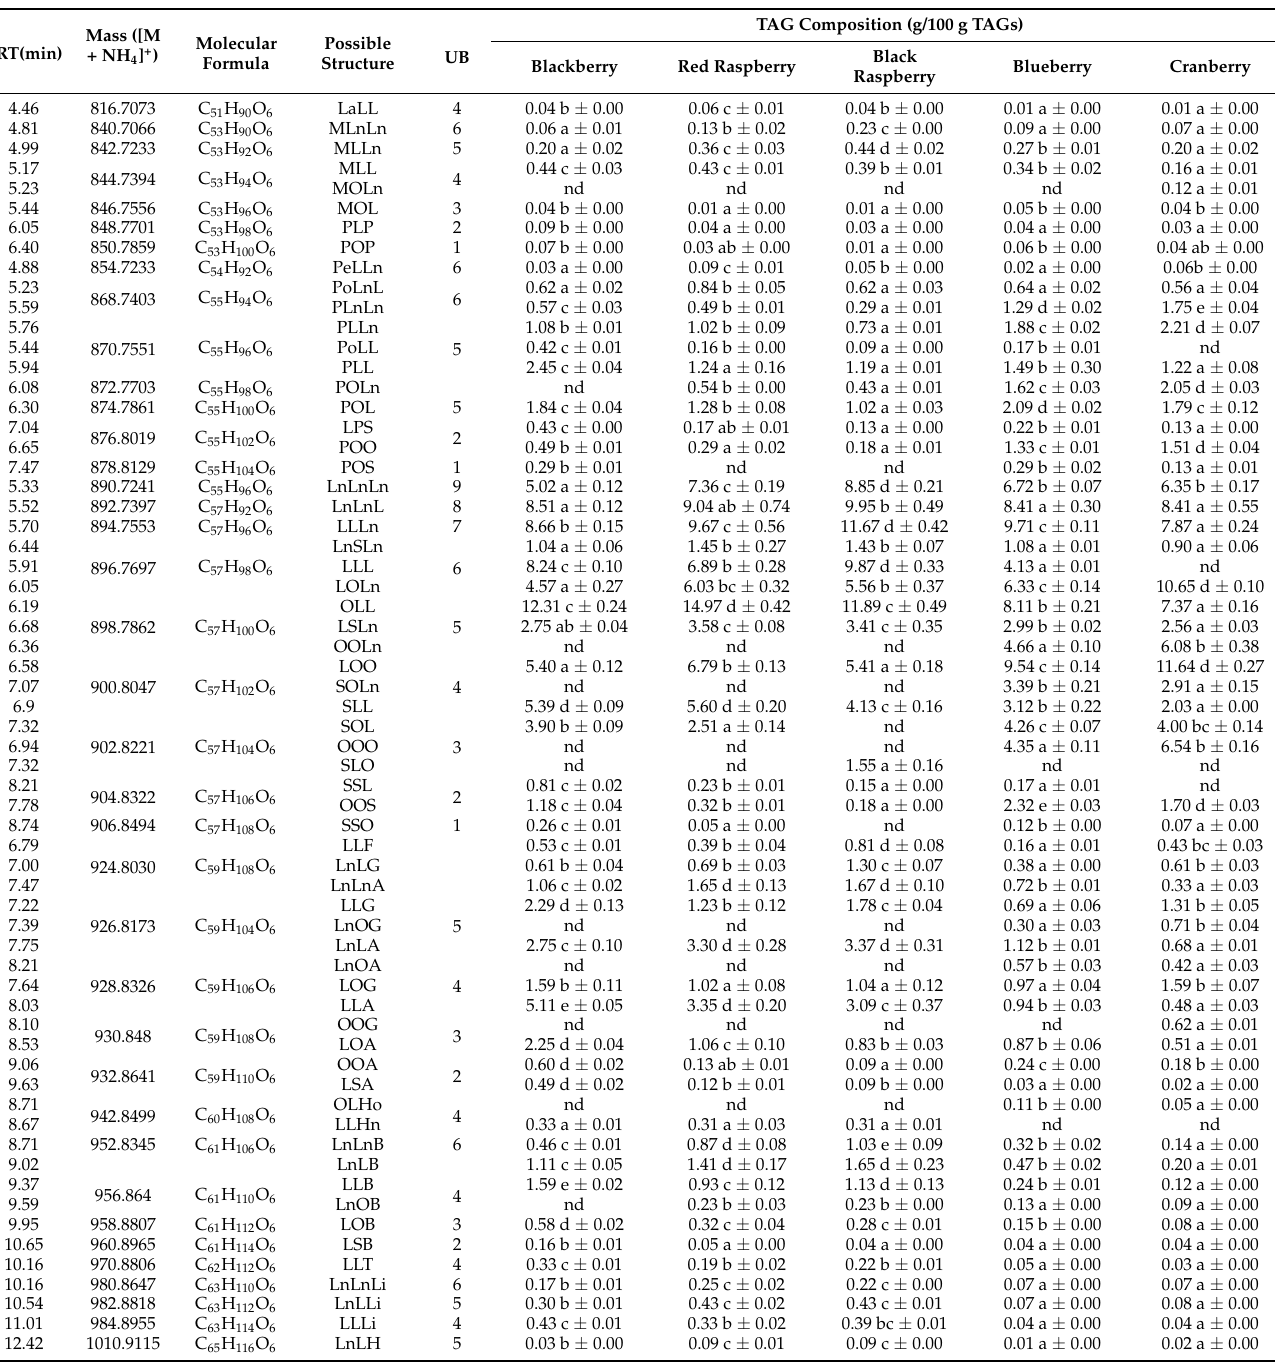
Table 1. Identification and relative concentration of triacylglycerols in five berry seed